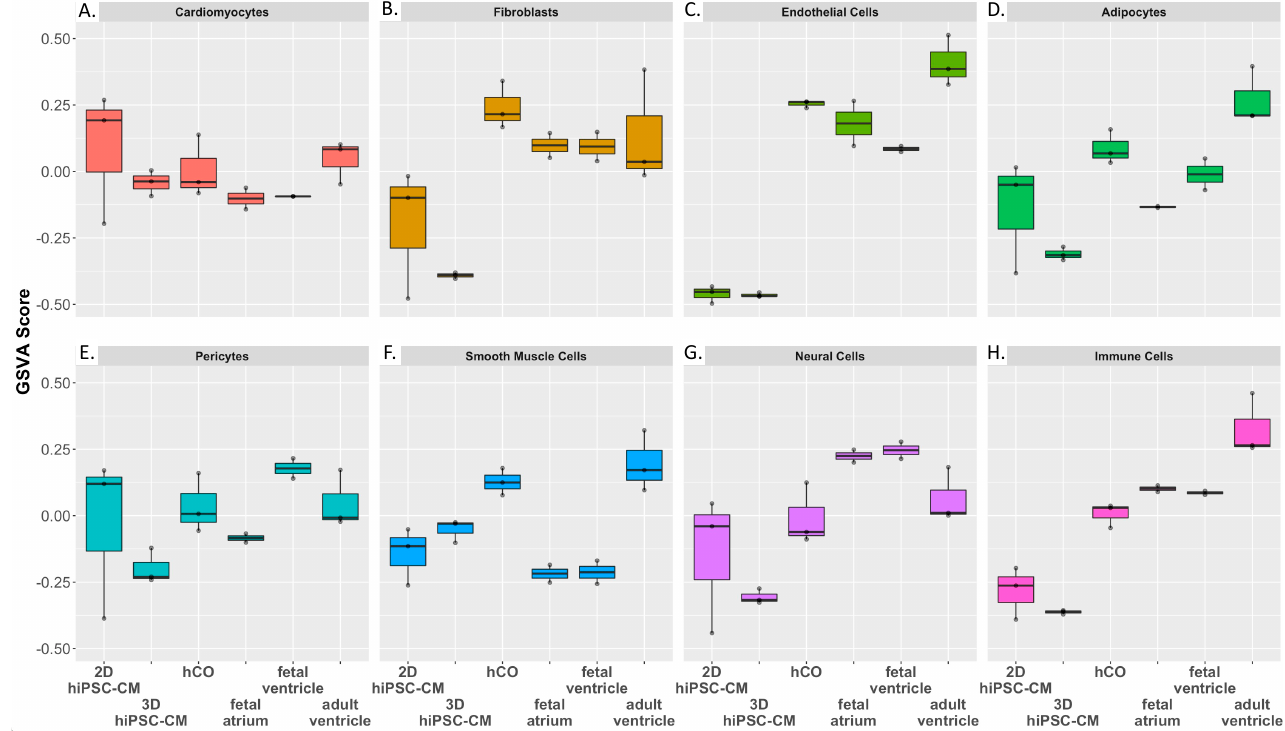
Figure 5. GSVA of in vitro models and human myocardium. GSVA was performed using cell-type specific gene sets from the Heart Cell Atlas. The following self-defined cell-type specific gene sets were created: ( A ) Cardiomyocytes, ( B ) Fibroblasts, ( C ) Endothelial cells, ( D ) Pericytes, ( E ) Smooth Muscle Cells, ( F ) Neural Cells, ( G ), Adipocytes and ( H ) Immune Cells.